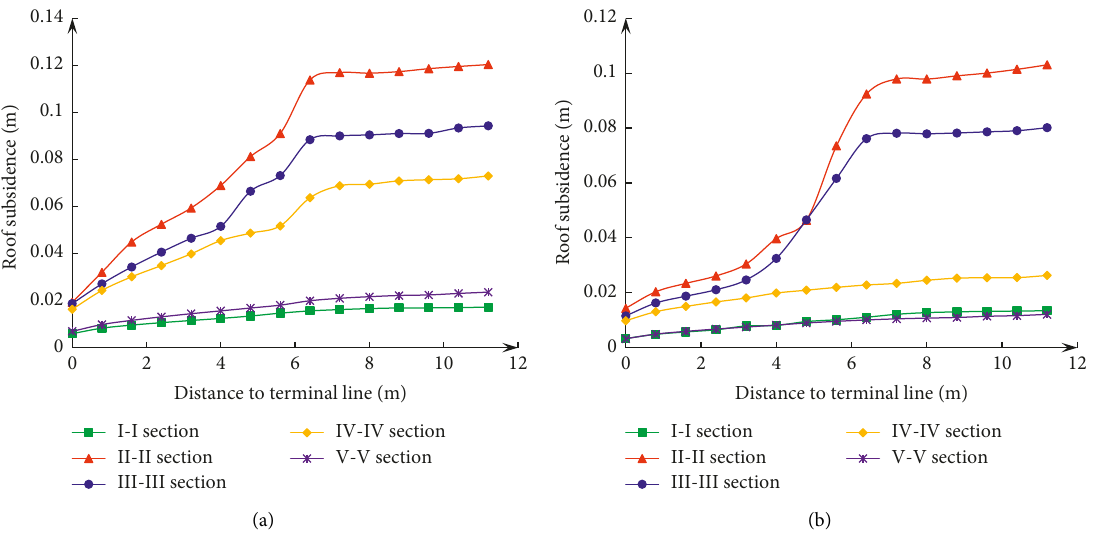
Figure 16: Roof subsidence curves of the two support designs. (a) Initial design. (b) Improved design.